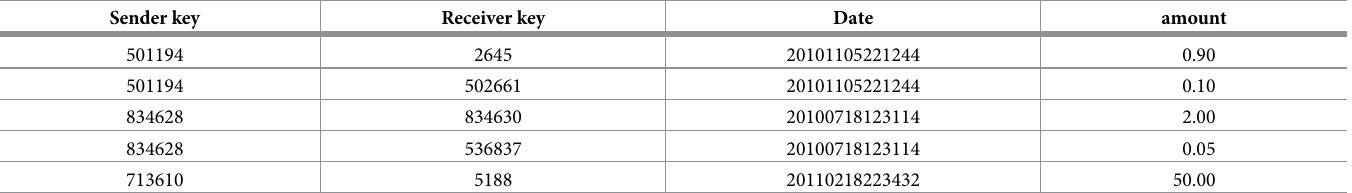
Table 1. An example of the dataset obtained using the Reid and Harrigan method [2]. The data contains information on the users’ ID (both sender and receiver), exact time, and amount of transaction. Sender